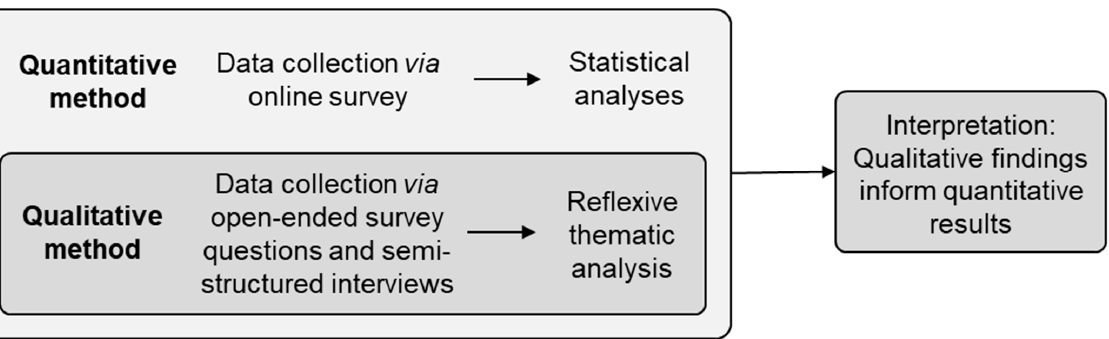
Figure 1. Embedded mixed-methods design.